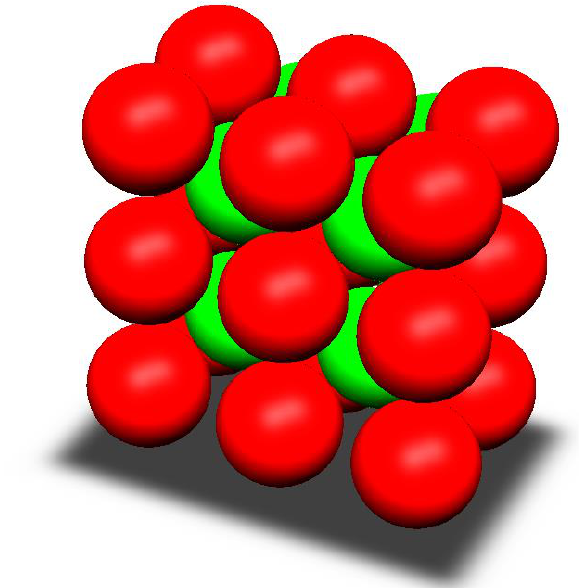
Fig. 2. Axonometric view of the analysed packed bed of granular material.